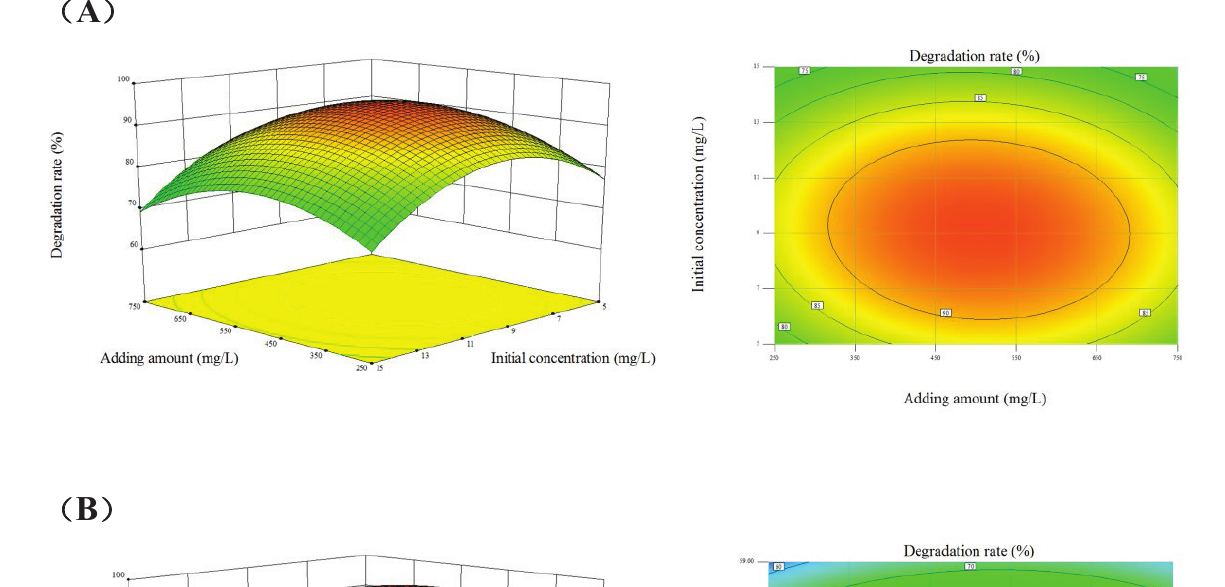
powder catalyst 2